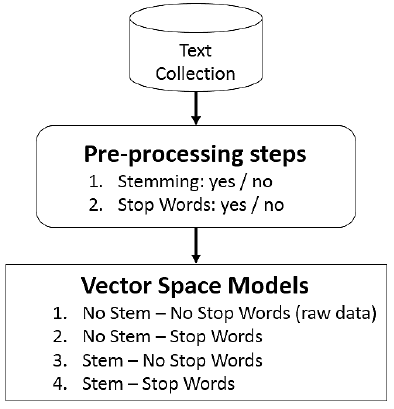
Figure 7. Pre-processing pipelines for opinion mining.